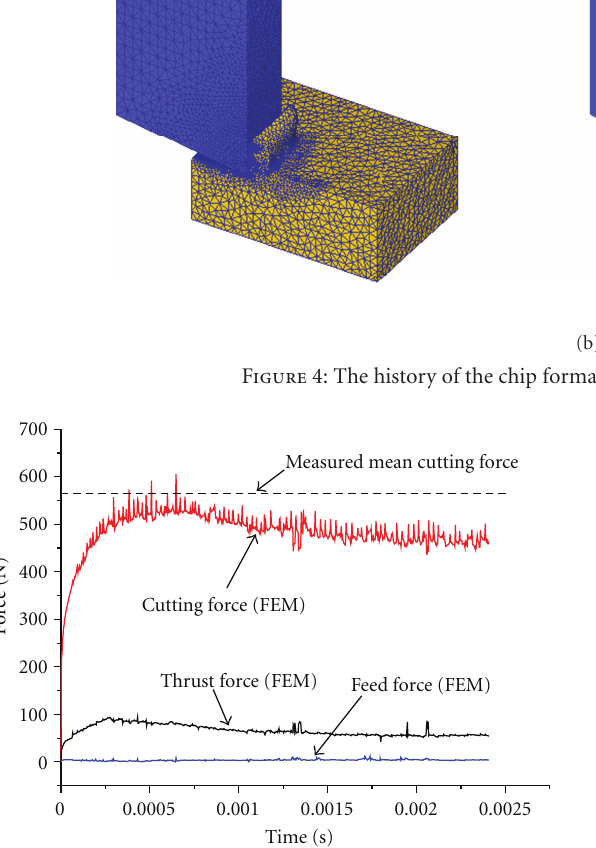
Figure 5: A comparison of simulated forces with experimental forces.